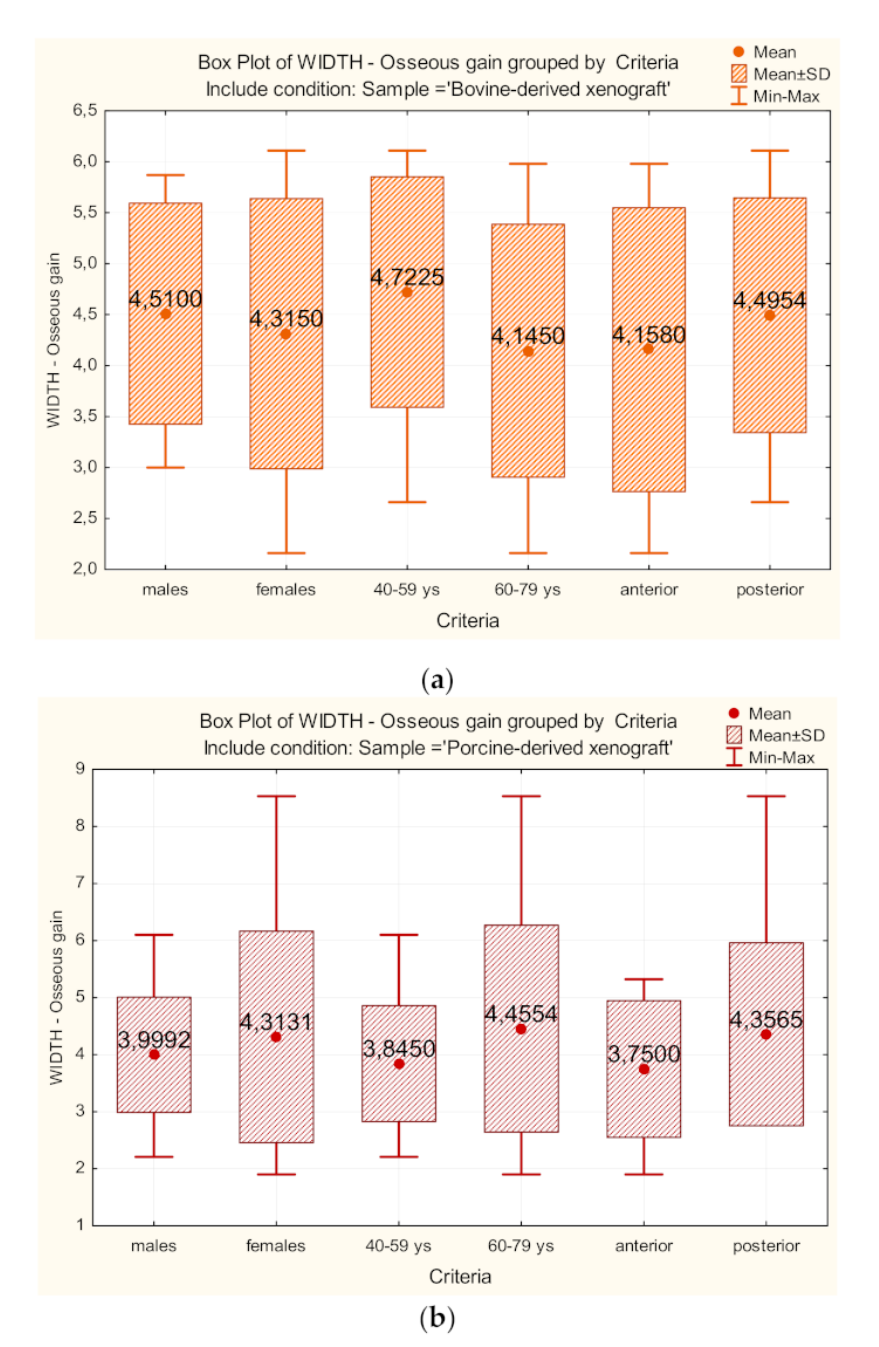
Figure 2. ( a ) Comparisons of bone gain (width) for sex, age groups, location of implant sites. Control group (S-GBR + bovine-derived xenograft). ( b ) Comparisons of bone gain (width) for sex, age groups, location of implant sites. Test group (S-GBR + porcine-derived